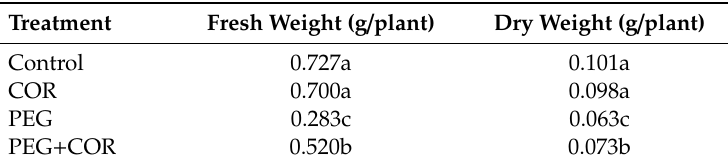
Figure 1. E ff ect of cornatine on Nipponbare rice seedlings under drought at 48 h. Control, Normal conditions without COR and PEG treatment; PEG, Water deficit treatment induced by PEG for 10 h without COR pretreatment; COR + PEG, Pretreatment with 0.1 µ M COR for 12 h before PEG treatment; COR, Treatment with 0.1 µ M COR alone, without PEG treatment; the same for the following tables and figures. Table 1. E ff ects of coronatine on biomass of Nipponbare rice seedlings under drought stress at seven days after the treatment.